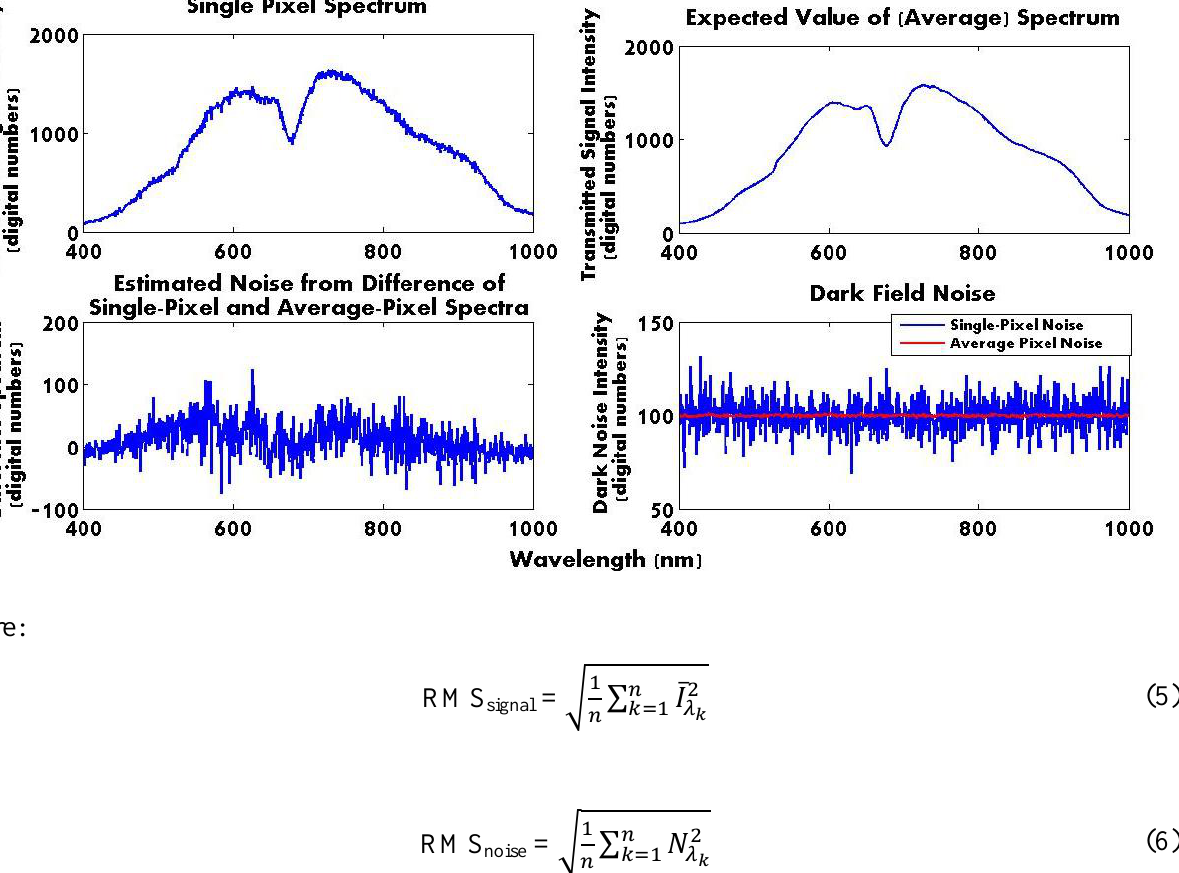
Figure 3. Noise characterization from a single spectrum ( Top left ), average spectrum ( Top right ), difference between the two ( Bottom left ) and dark field measurements ( Bottom right